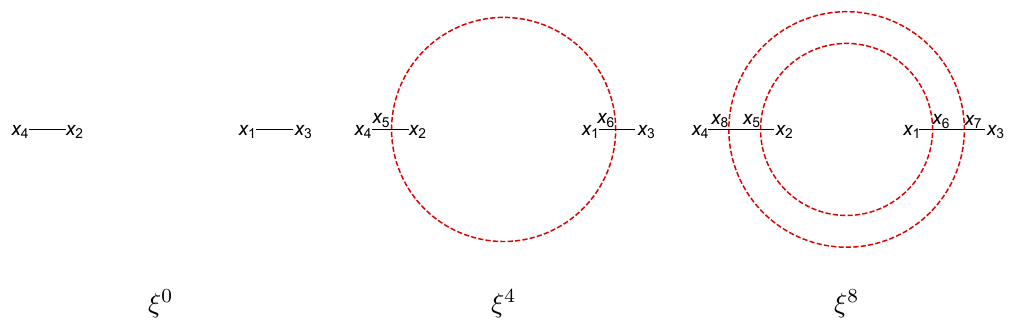
Figure 6 . First 3 orders contributing to the G 0